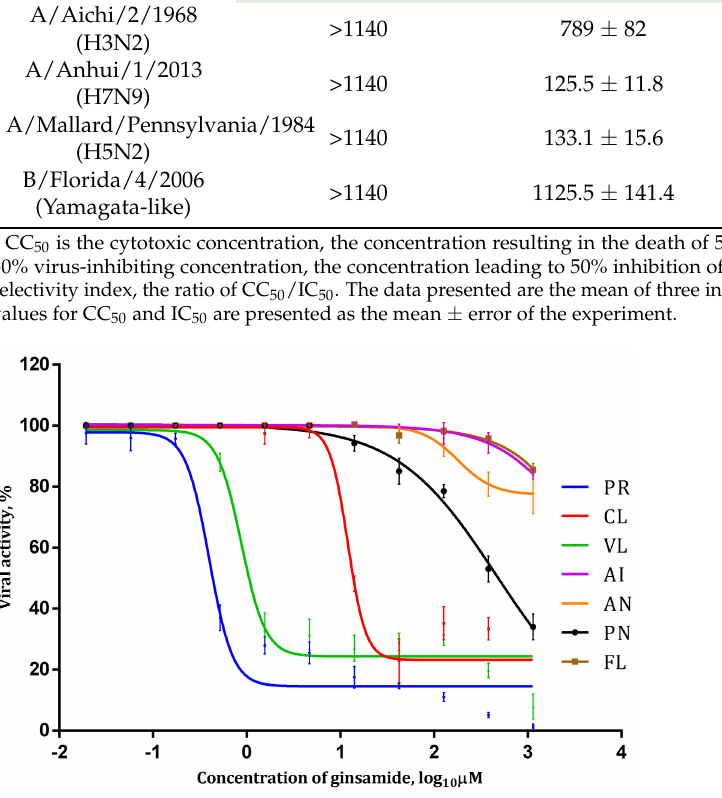
Figure 3. Virus-inhibiting activity of ginsamide against influenza viruses based on cytoprotection assay results. MDCK cells were infected with different influenza viruses (MOI 0.01) in the presence of serial dilutions of ginsamide. After incubation for 72 h, cell viability was evaluated by the MTT test. Virus designation: PR: A/Puerto Rico/8/34 (H1N1); CL: A/California/07/09 (H1N1)pdm09; VL: A/Vladivostok/2/2009 (H1N1); AI: A/Aichi/2/68 (H3N2); AN: A/Anhui/1/2013 (H7N9); PN: A/mallard/Pennsylvania/10218/84 (H5N2); FL: